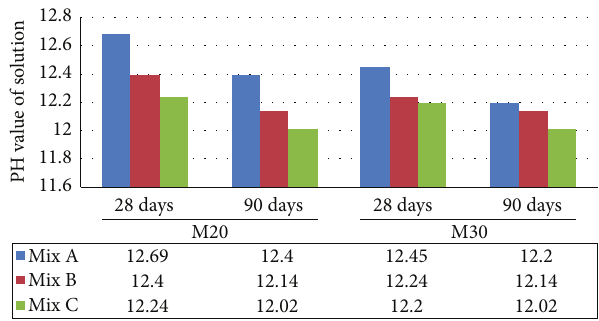
Figure 13: Comparative alkalinity test of Mix A, Mix B, and Mix C of M20 and M30 grade.